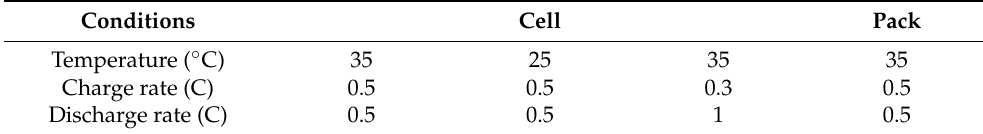
Table 2. Battery aging test conditions.